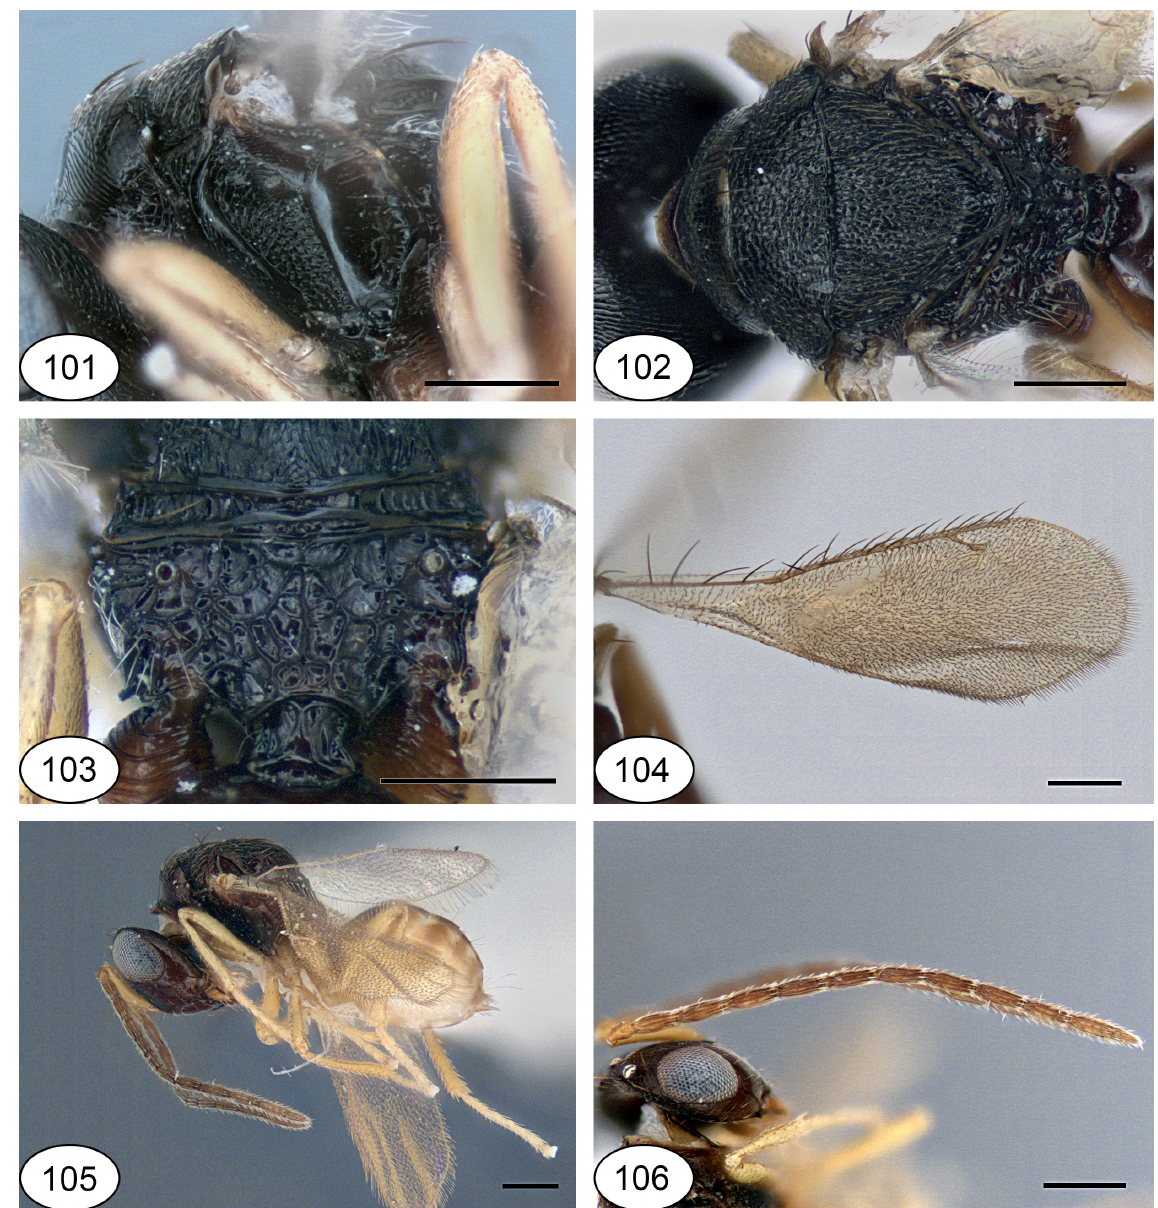
Figs 101–106. Netomocera masneri sp. nov. 101 . Holotype, ♀, mesosoma, lateral view. 102 . Holotype, ♀, mesosoma, dorsal view. 103 . Holotype, ♀, propodeum, dorsal view. 104 . Holotype, ♀, fore wing. 105 . Allotype, ♂, habitus, lateral view. 106 . Allotype, ♂, antenna. Scale bars: 0.2